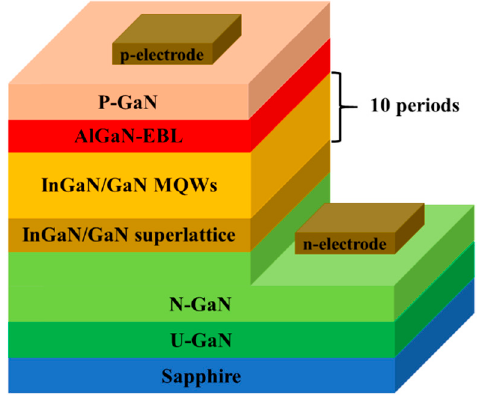
Figure 2. Structure diagram of green-yellow LED.